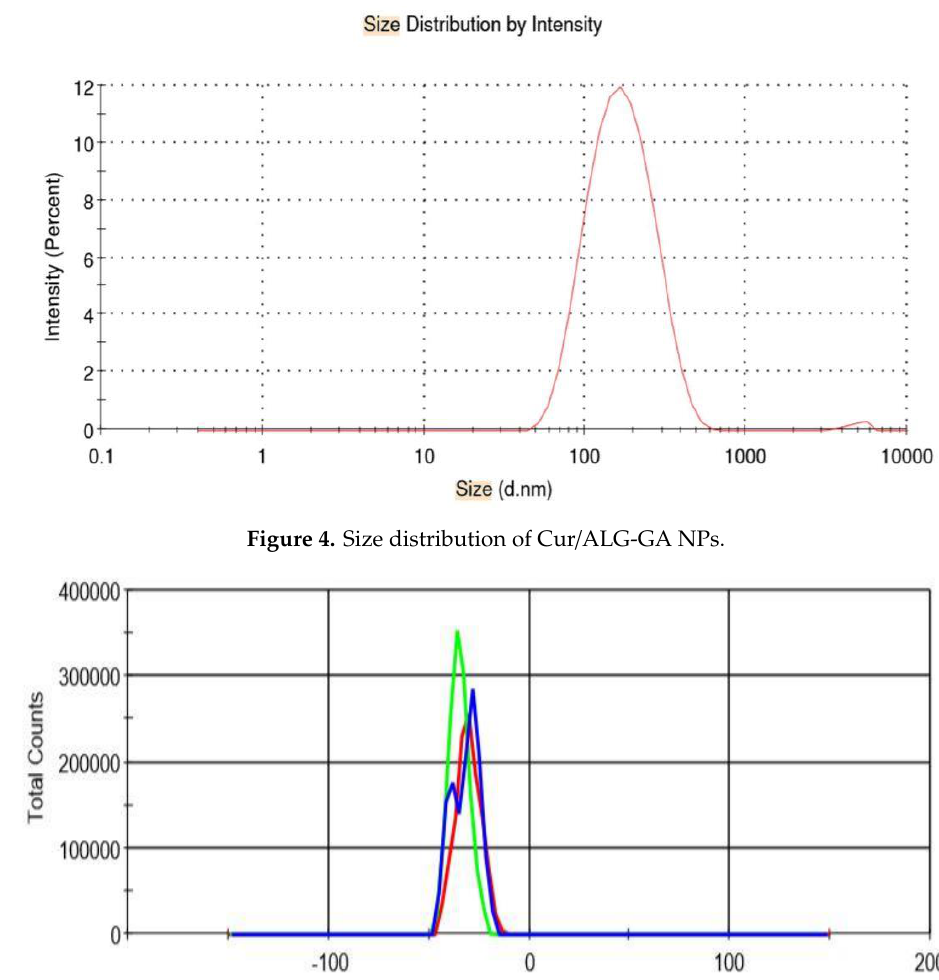
Figure 5. Zeta potential of Cur/ALG-GA NPs.